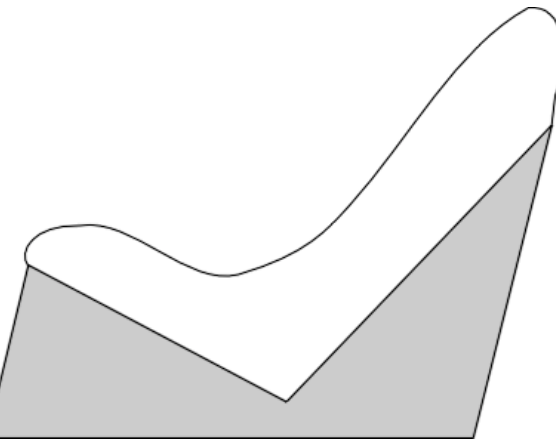
Figure 6. Soft chair of modern design made of expanded foam contained in a metallic frame.